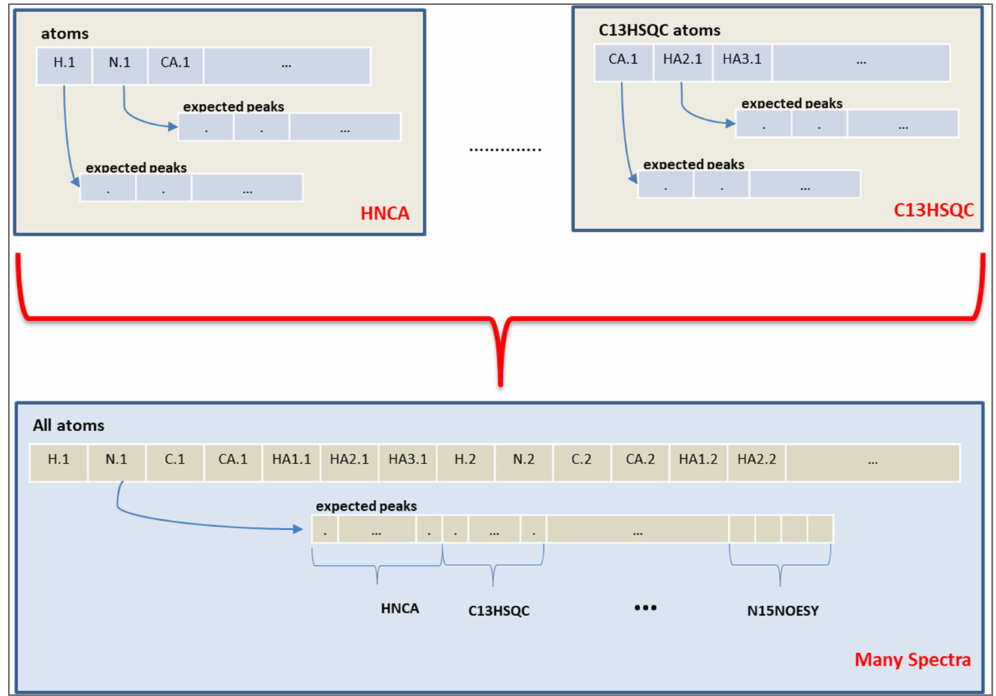
Figure 4. Atoms of an expected peak. The upper part shows the atom representations for two spectra, HNCA and C13HSQC in this example. The lower part shows the atom representation for the expected peaks in multiple